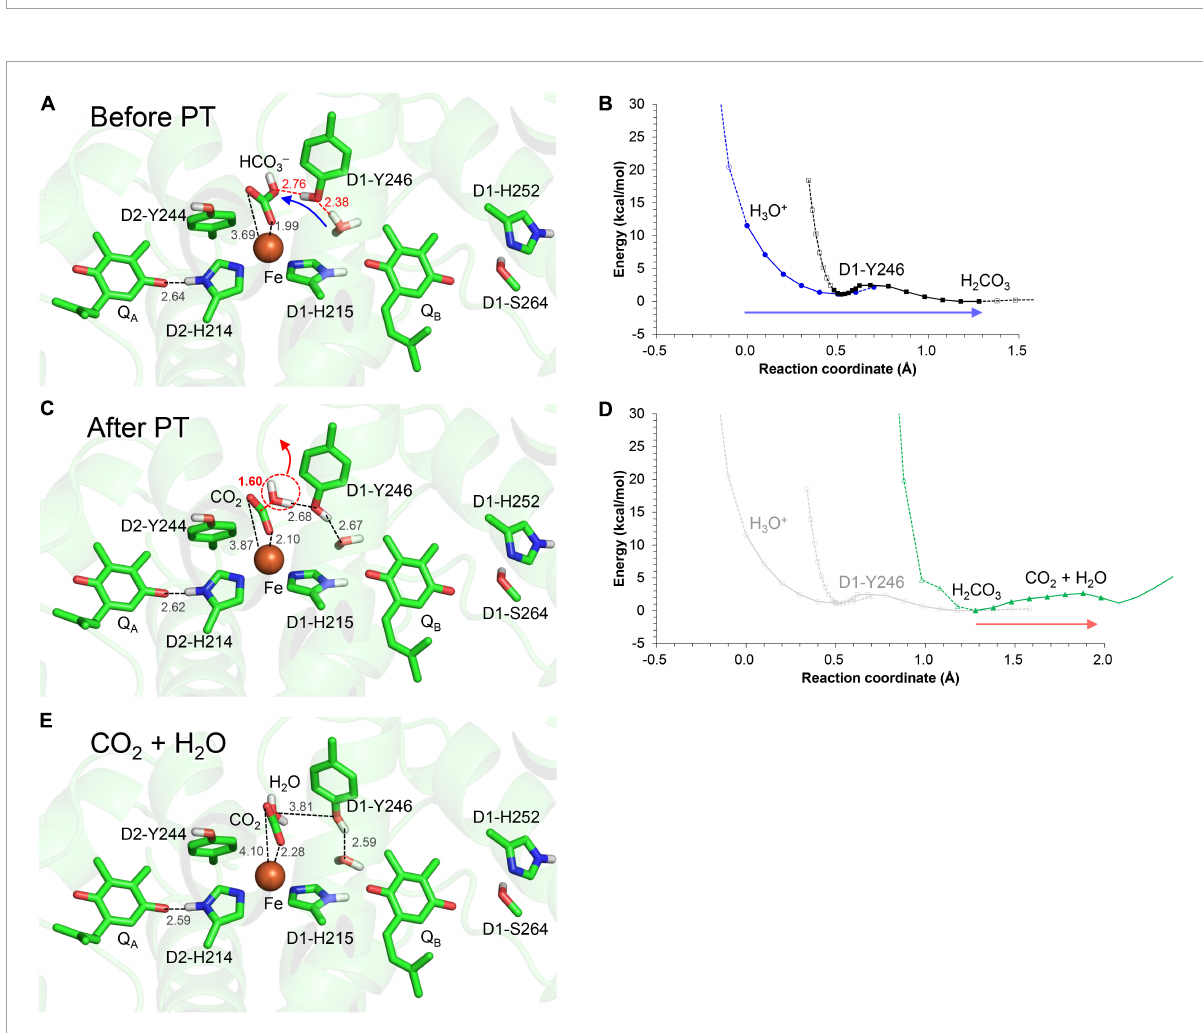
FIGURE7 H-bond network via D1-Tyr246 to the monodentate bicarbonate ligand. (A) QM/MM-optimized geometry before proton transfer. (B) Potential energy profile for proton transfer along the H 3 O + ... D1-Tyr246 ... bicarbonate H-bond network. (C) QM/MM-optimized geometry after proton transfer. (D) Potential energy profile for CO 2 release from the monodentate binding site. (E) QM/MM-optimized geometry after decomposition to H 2 O and CO 2 . Blue arrows indicate the orientations of the proton transfer. Red arrows indicate the orientations of the structural changes. Note that the geometry of each intermediate conformation is fully QM/MM